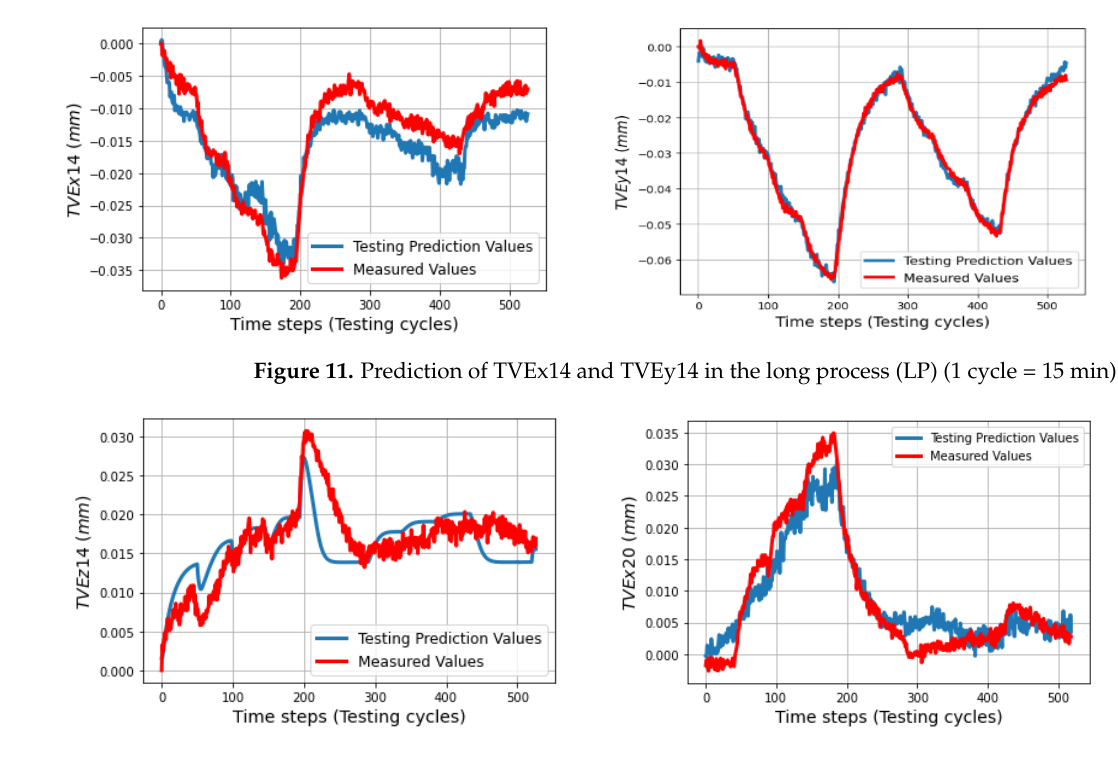
Figure 12. Prediction of TVEz14 and TVEx20 in the long process (LP) (1 cycle = 15 min) .